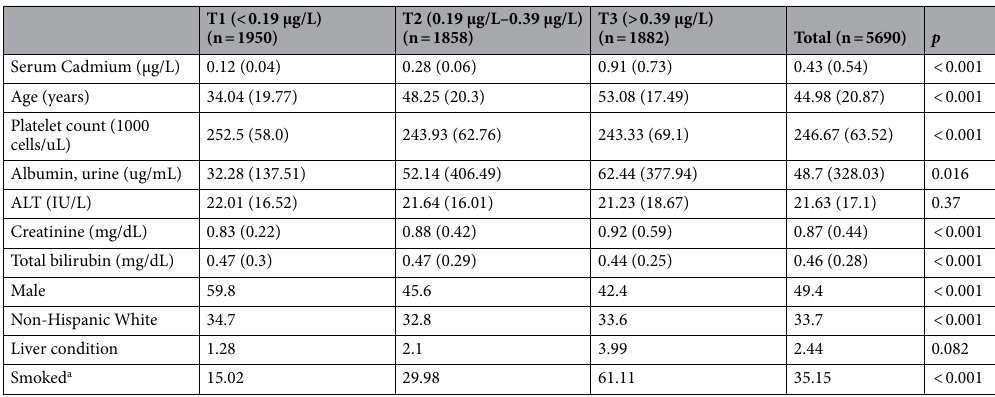
Table 3. Characteristics of study participants by tertiles of serum cadmium concentration (µg/L). a “Smoked” was defined as ever smoked at least 100 cigarettes in a